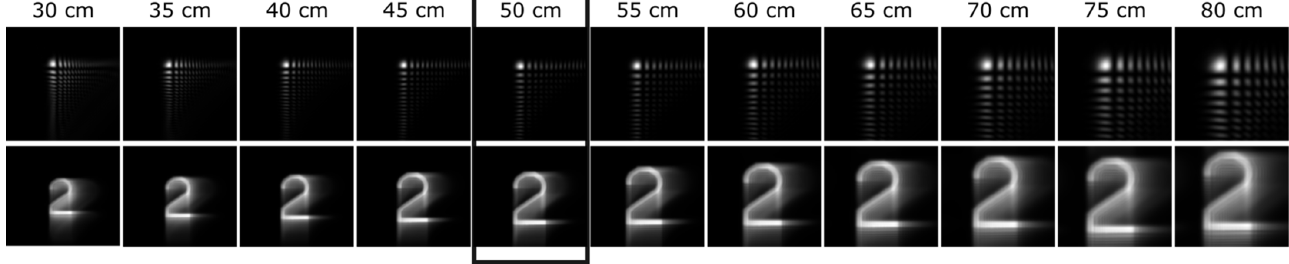
Figure 6. Numerical simulation of the PSFs (top) and the images of the extended object (bottom) for the combined APM + FL imaging system with the optimized value α = 100/ π along the z’-image plane range (rectangle in the in-focus position). The pupil size was L = 8.64 mm.